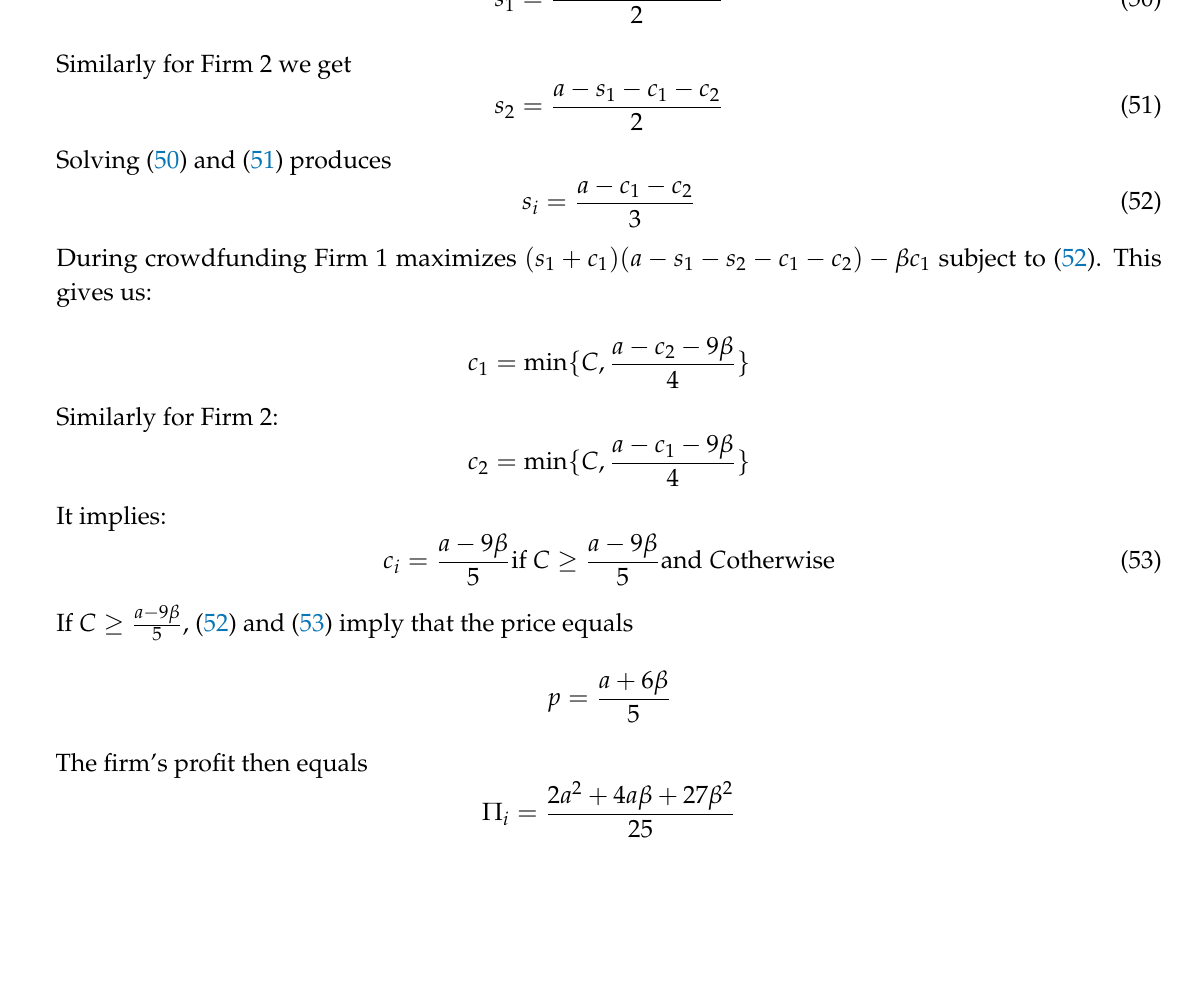
Figure 6. ( a ) Matrix of payoffs if C ≥ a − 9 β payoffs if C < a